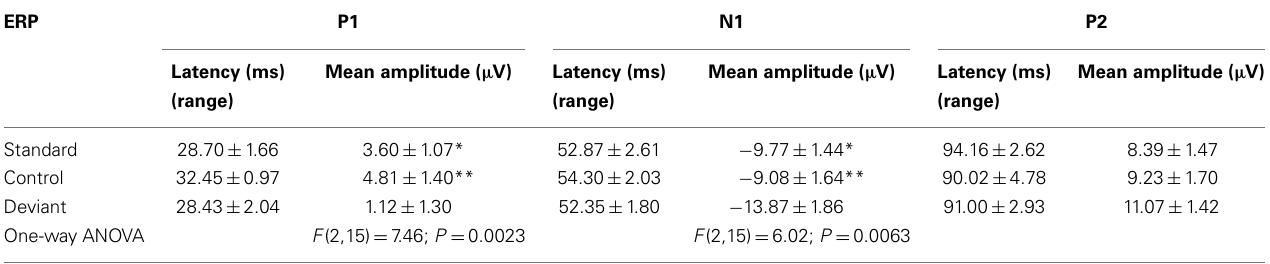
Table 1 | ERP component latency and amplitude under three conditions of evocation .